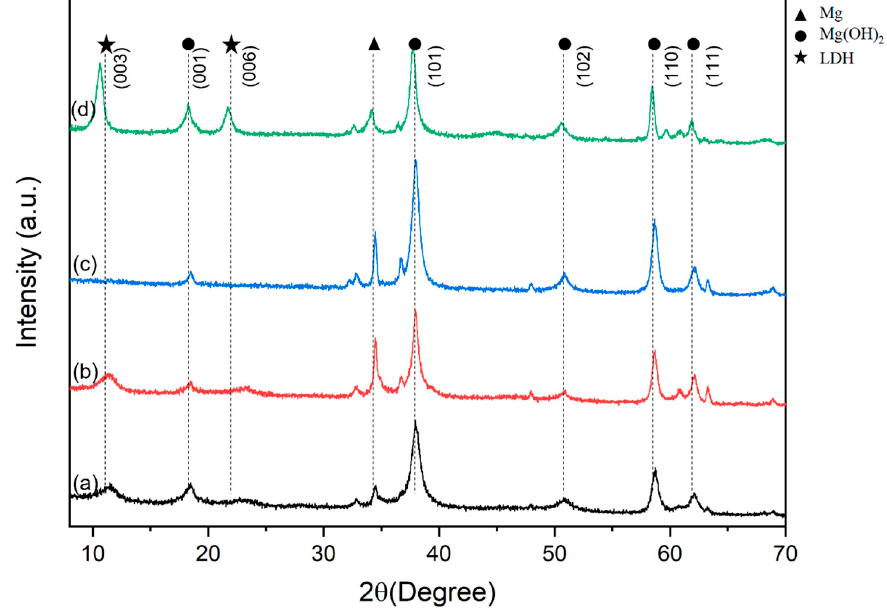
Figure 9. XRD diagrams of ( a ) A1124, ( b ) A1024, ( c ) E1124, and ( d ) E1024, after 7 days immersion in 0.1 M NaCl solution.